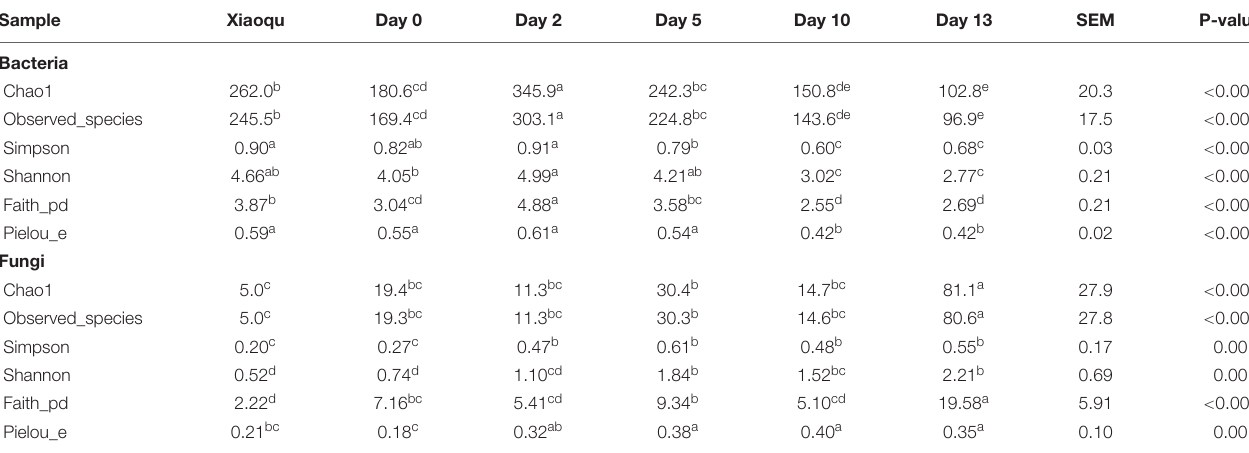
TABLE 1 | Alpha diversity of bacteria and fungi based on high throughput sequencing.